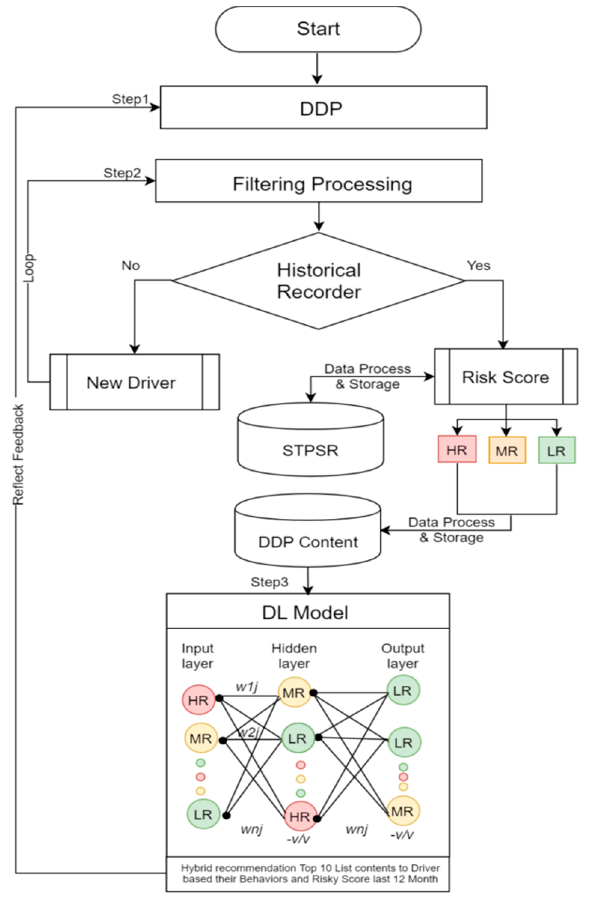
Figure 9. DL prediction model for driver risk classification.